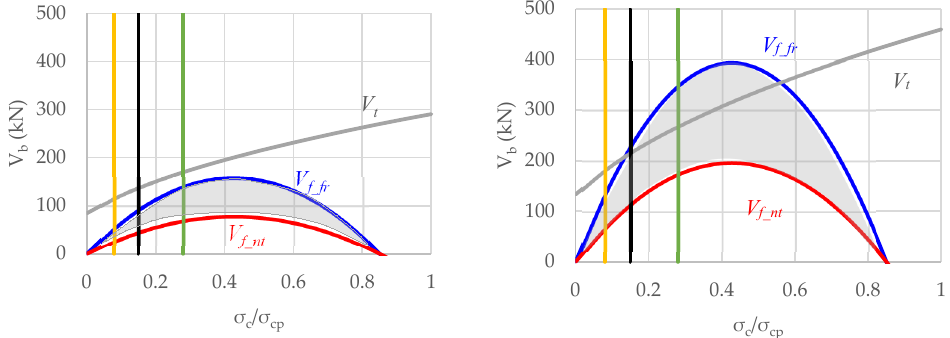
Figure 4. Resistance domains of masonry piers P1 ( left ) and P2 ( right ). Vertical lines correspond to VL-a (yellow line), VL-b (black line), and VL-c (green line). Grey lines correspond to the shear capacity V t , and the red and blue curves refer to flexural capacities corresponding to free rotation ( V f_fr ) or absence of rotation at the top of the panel ( V t_nr ), respectively.